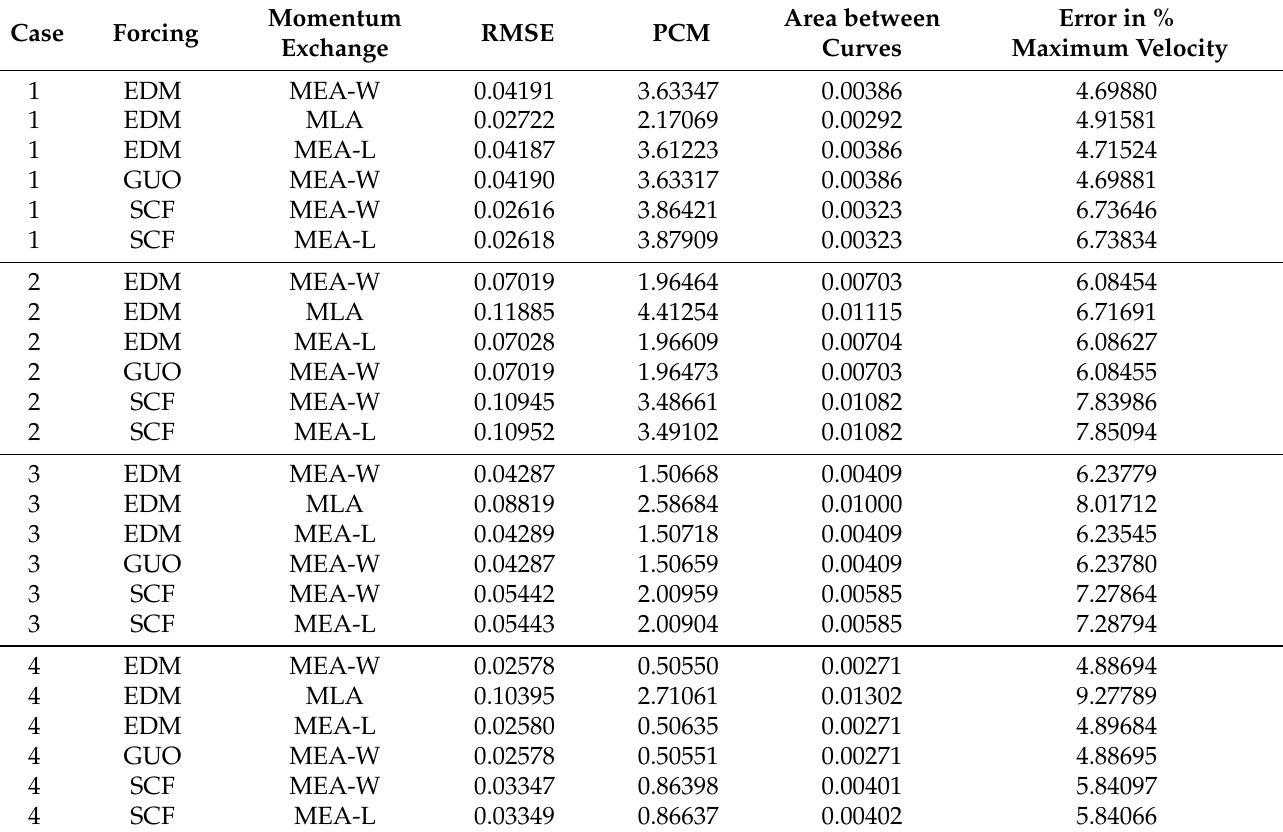
Table 2. Different error measures [80] for the four cases described by ten Cate et al. [45] for various combinations of momentum exchange and forcing schemes. The error in terminal velocity is given relative to the analytical values according to Abraham [60]. The results in the table refer to N =